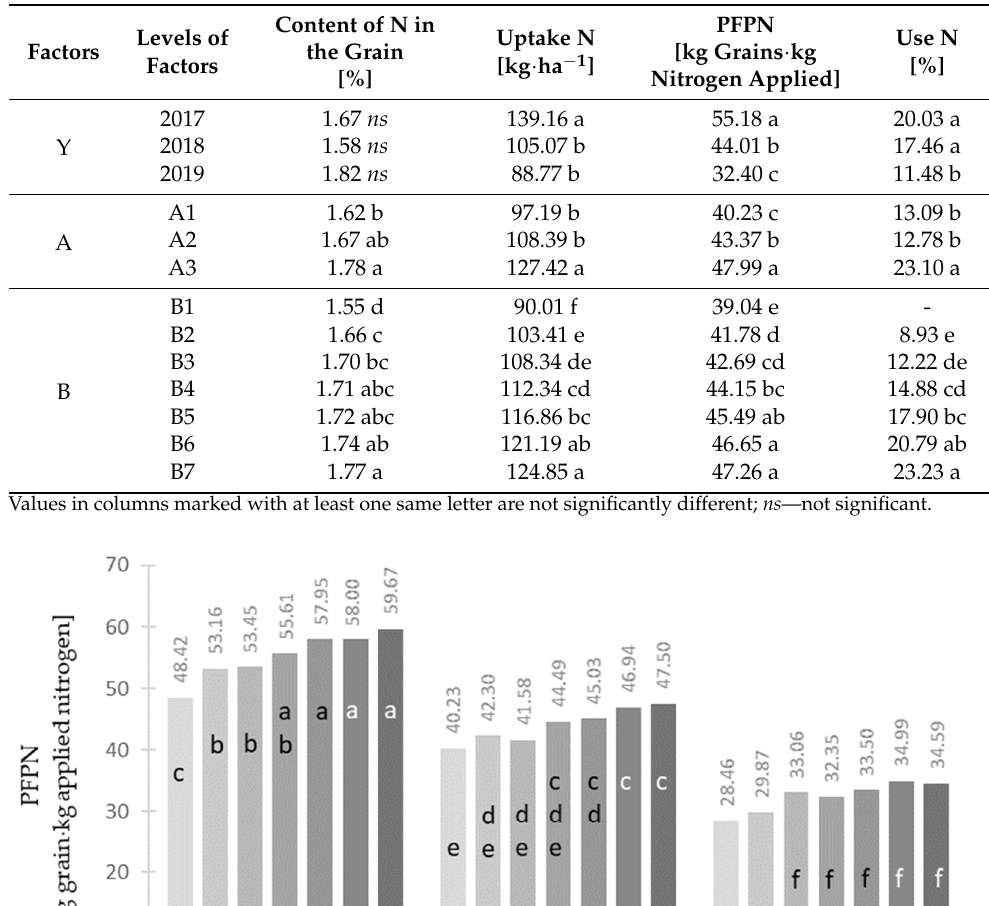
Table 3. Average values of nitrogen utilization efficiency indicators for years (Y), cultivars (A), and fertilizer (B).